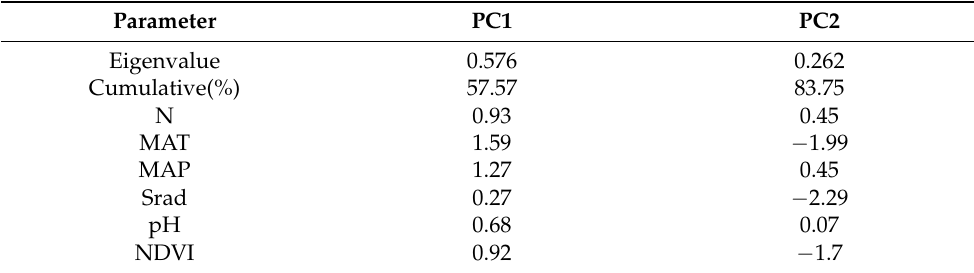
Table 4. Basic characteristics of the first 2 axes of PCA sorting.